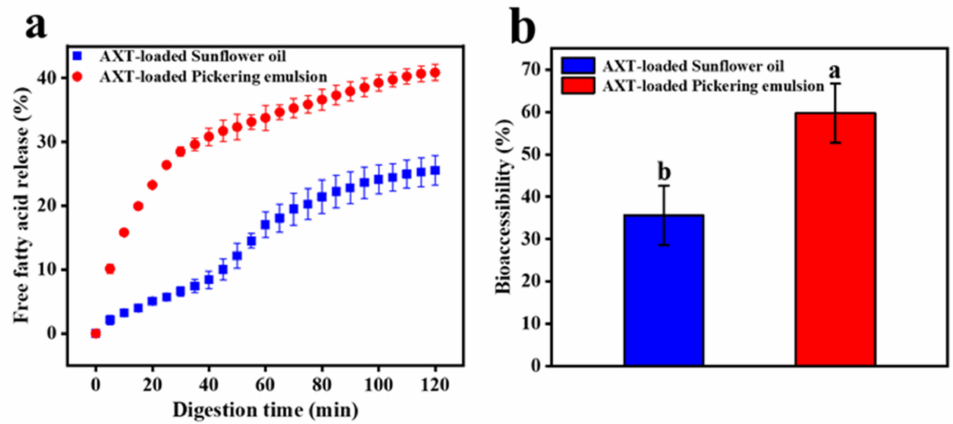
Figure 9. The release of FFAs ( a ) and bioaccessibility of AXT ( b ) of AXT-loaded Pickering emulsions and sunflower oil in simulated intestinal fluid. Different letters of a and b show significant